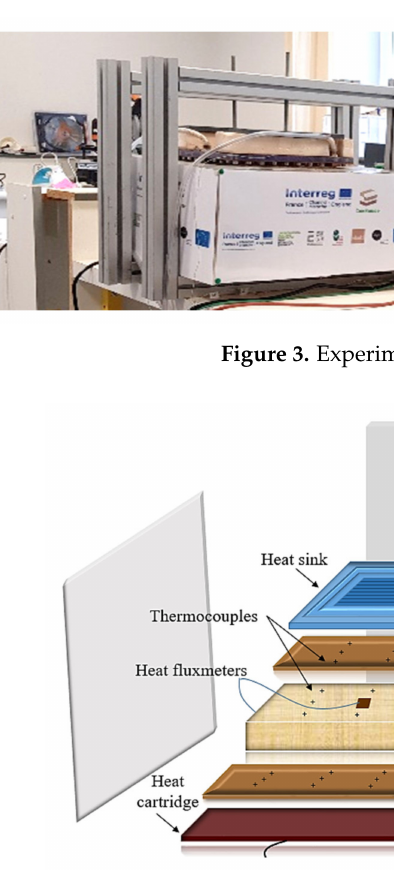
Figure 4. Test section.